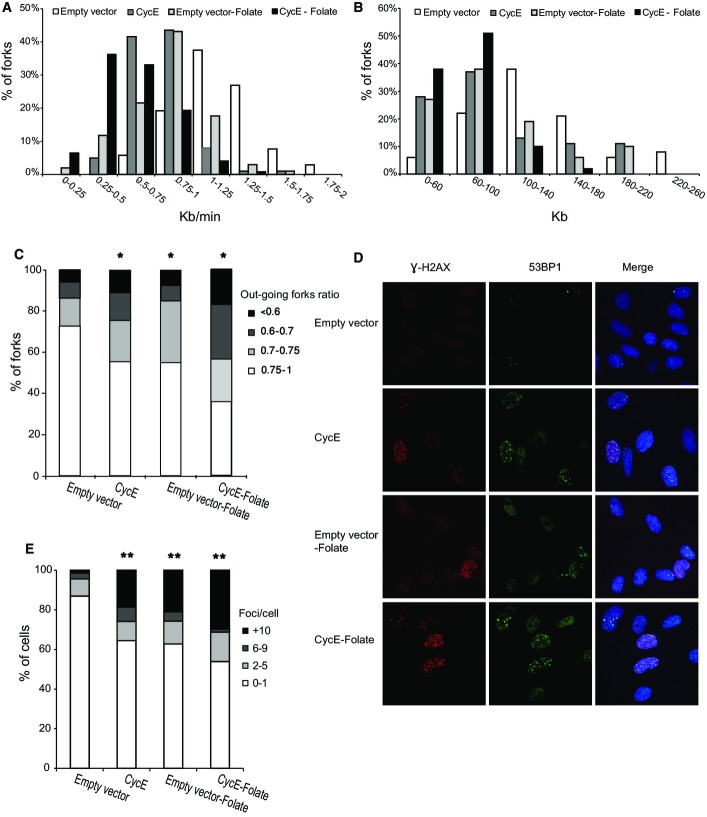
The effect of folate deficiency on replication dynamics and DSB formation in cyclin E-expressing cellsCyclin E-expressing BJ cells were grown for 7 days with and without folate.
Fork rate (Kb/min) distribution. White bars: BJ cells expressing an empty vector (n = 145); dark gray bars: BJ cells expressing the cyclin E oncogene (n = 147); light gray bars: BJ cells cultured for 7 days in a folate-free medium (n = 135); black bars: BJ cells expressing the cyclin E oncogene cultured for 7 days in a folate-free medium (n = 138).

Fork distance distribution (Kb). The color code is as in (A). Empty vector (n = 78); CycE (n = 79); empty vector −folate (n = 71); CycE −folate (n = 80).

Percent of origins with the indicated progression ratio between sister forks. Empty vector (n = 158); CycE (n = 155); empty vector −folate (n = 160); CycE −folate (n = 154). *P < 0.05.

Examples of nuclei with γH2AX and 53BP1 foci following cyclin E expression (CycE) (n = 65), empty vector (n = 65), folate-free medium for 7 days (empty vector −folate) (n = 67) or oncogene expression under folate-free conditions (CycE −folate) (n = 70). Red: γH2AX; green: 53BP1; blue: DAPI staining.

Percent of nuclei with the indicated number of γH2AX-53BP1 co-localized foci. **P < 0.01.
Data information: Bars represent average values.